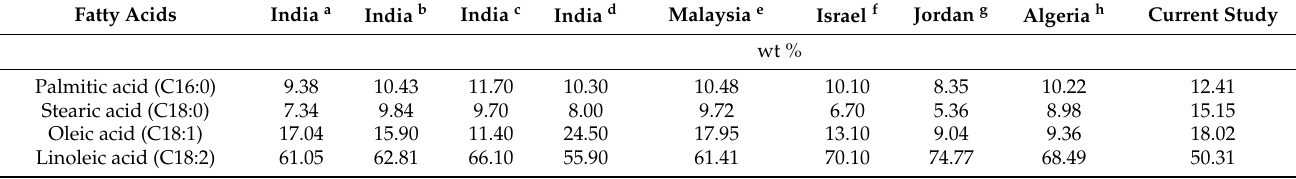
Table 2. Comparison of the major fatty acid composition (by weight %) of tumba ( Citrullus colocynthis L.) seed obtained in the present study with that obtained in other countries and regions of the world.